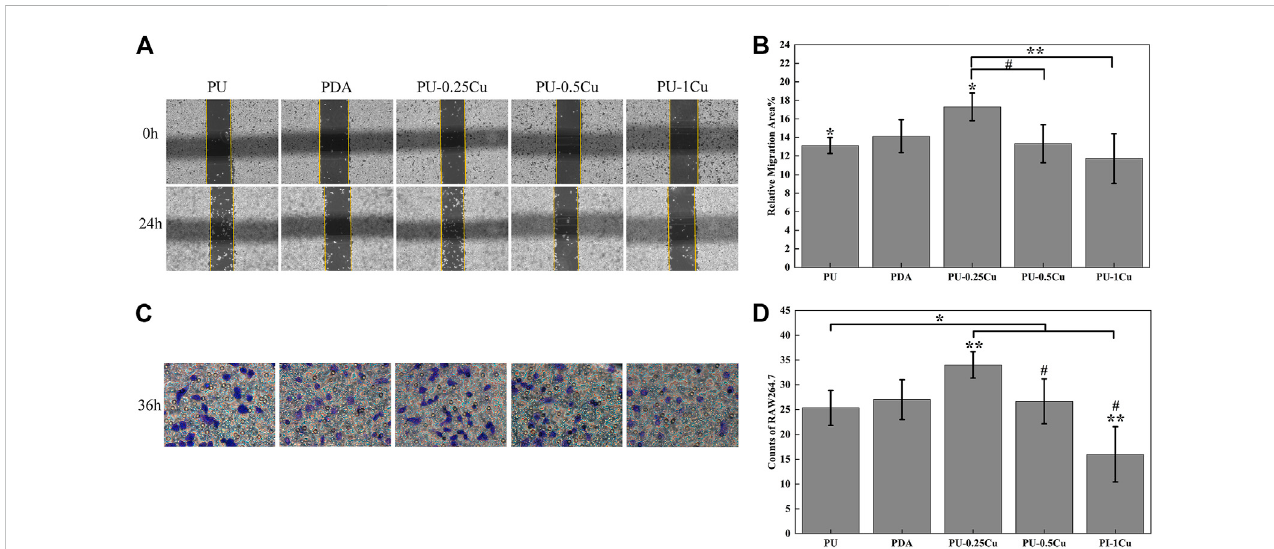
FIGURE 7 (A) Wound healing assay imaged using an optical microscope, magni fi ed 100 times at 0 and 24 h. (B) Relative migration area of samples. (C) Transwell assay recorded using an optical microscope at 36 h. (D) Number of cells migrated through the membrane for 36 h. The statistically signi fi cant difference at p < 0.05 is shown as *p < 0.05 and # p < 0.05. p < 0.01 is shown by different letters **p < 0.01